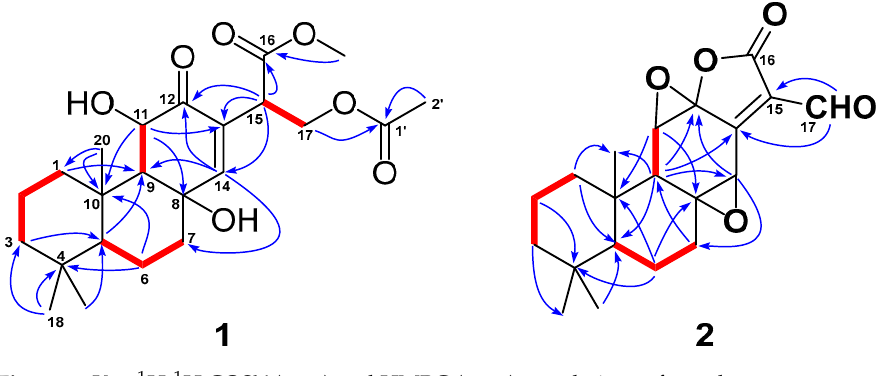
Figure 2. Key 1 H- 1 H COSY ( ) and HMBC ( ) correlations of 1 and 2 . The NOESY correlations (Figure 3) of H-5/H-9 indicated that these protons were co- facial and were arbitrarily assigned to be β -oriented, while the NOESY correlation of H 3 - 20/H-11 indicated that these protons were α -oriented. However, the NOESY spectrum did not give useful signals to determine the relative configuration of C-8 and C-15. To